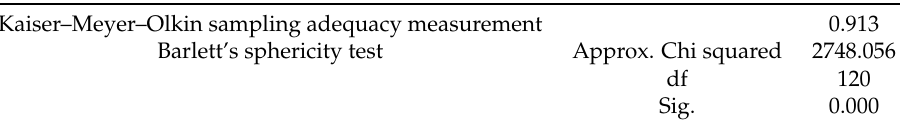
Table 8. Kaiser–Meyer–Olkin and Bartlett Test.